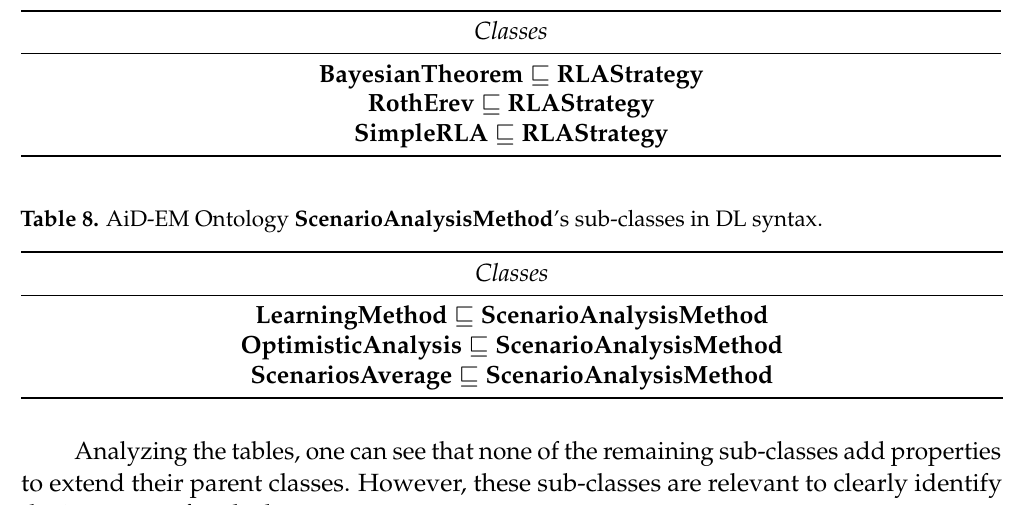
Table 7. AiD-EM Ontology RLAStrategy ’s sub-classes in DL syntax.